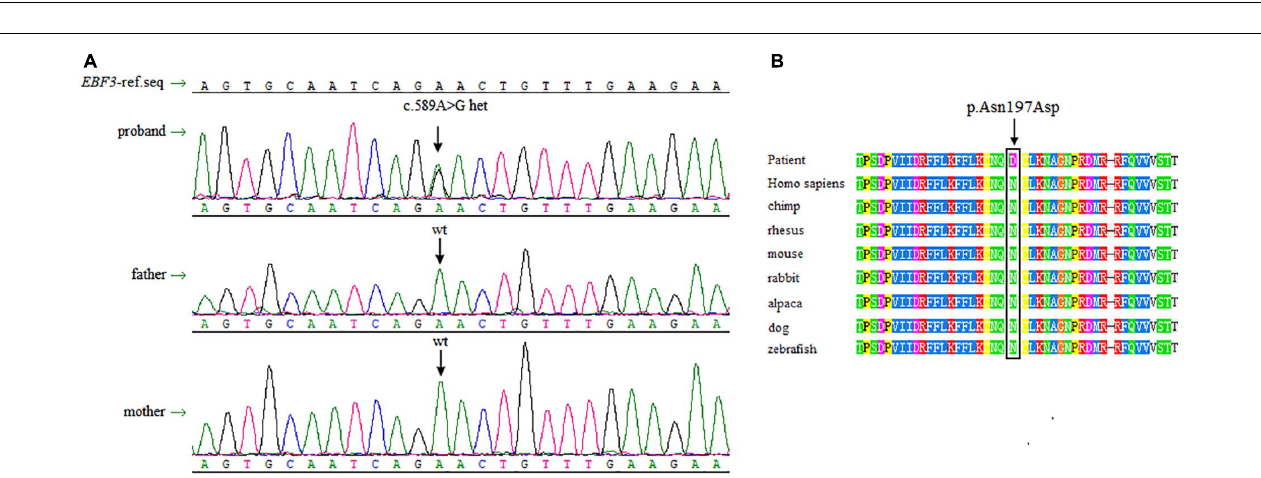
FIGURE 1 | The appearance and MRI results of the patients. (A) The patient has an unclosed fontanelle, slight orbital hypertelorism, high nasal bridge, broad nasal tip, deep philtrum, and downturned mouth. (B) The patient has pectus excavatum. (C) The hemangiomas are in the palm of the left hand. (D,E) Brain MRI shows insignificant T2 hyperintensity at the bilateral anterior limbs of the internal capsule, enlargement of the bilateral lateral ventricles and lateral apertures.